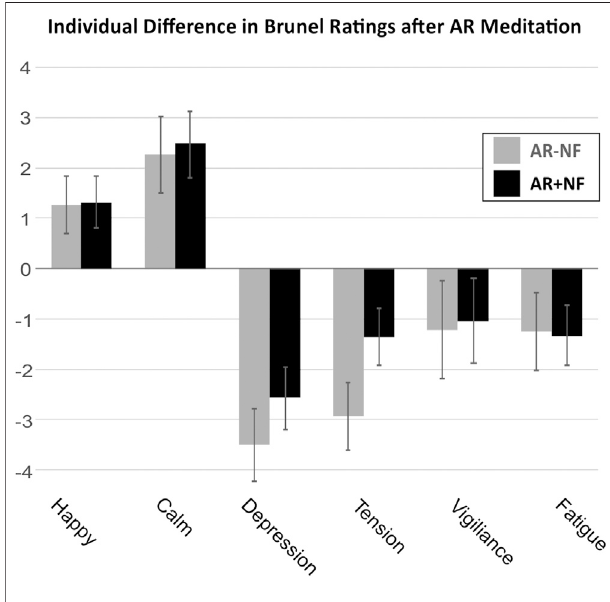
FIGURE2| Meandifferenceofratingonquestionnairesubscalespre-to- post AR meditation. Both groups demonstrated signi fi cant pre-to-post changes across subscales, with the exception of the vigilance subscale. No signi fi cant differences occurred between groups or as interaction effects. Mean of differences and standard errors of the mean are shown.